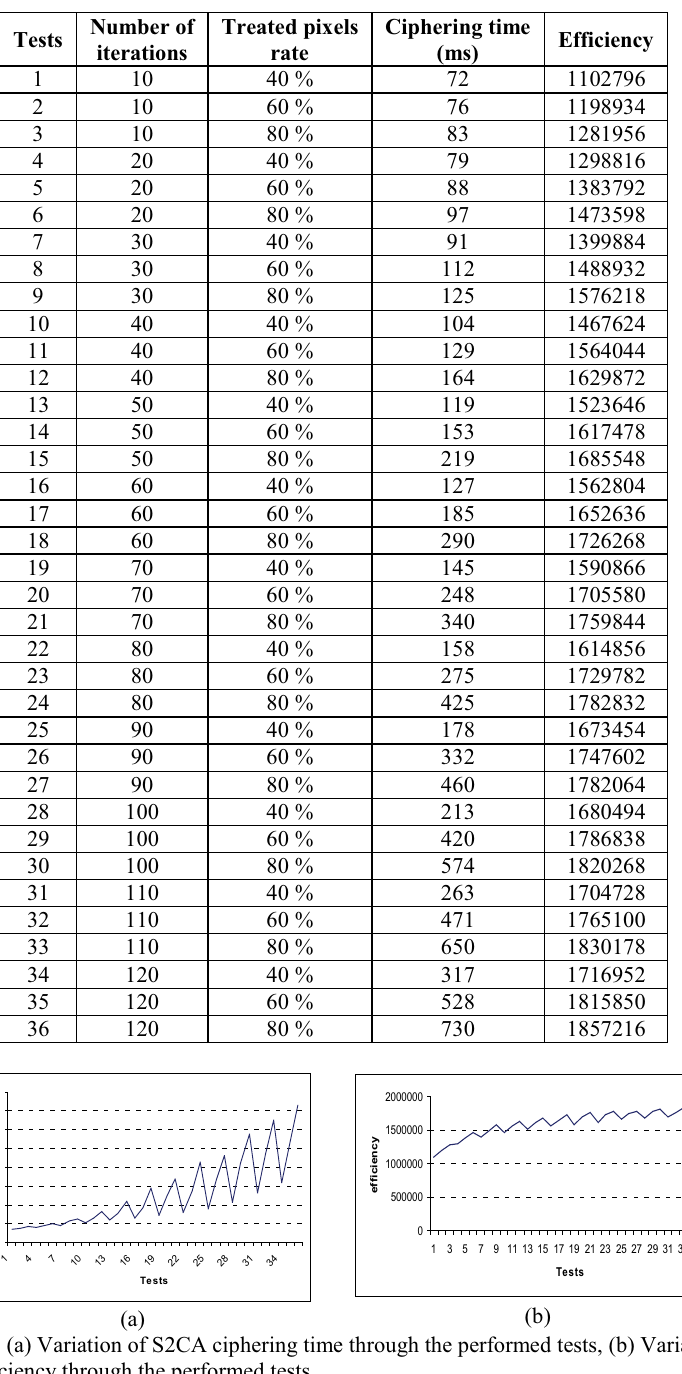
Table 3. Evolution of S2CA efficiency and ciphering time according to the number of iterations and the processed pixels rate.